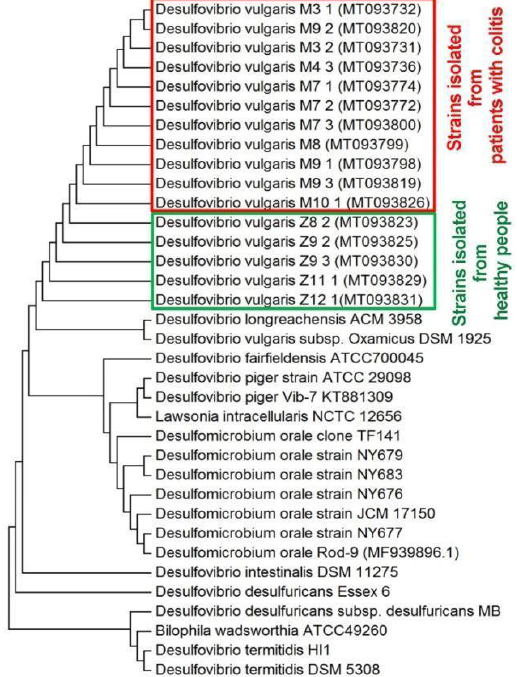
Figure 2. Phylogenetic tree based on sequences analysis of the 16S rRNA gene known and studied intestinal SRB strains (built by the neighbor-joining method).